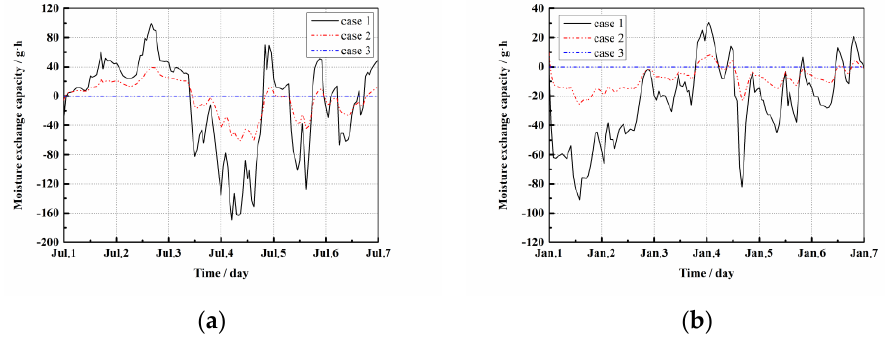
Figure 12. Moisture exchange on the internal surface of the rammed earth wall: ( a ) in summer; ( b ) in winter.